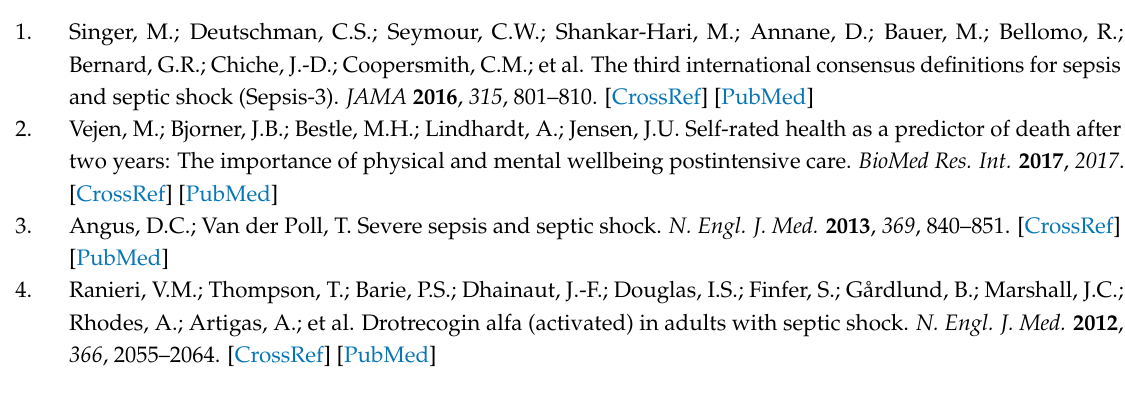
Figure 1. A suggestion for how to translate discoveries from ‘omics’ data to clinical practice.